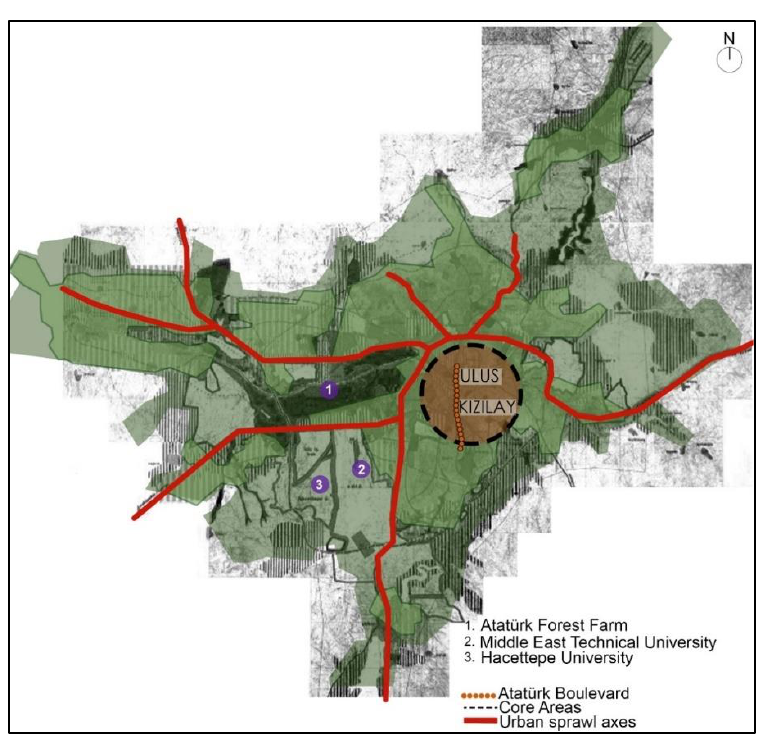
Figure 11 1990 Master Plan.